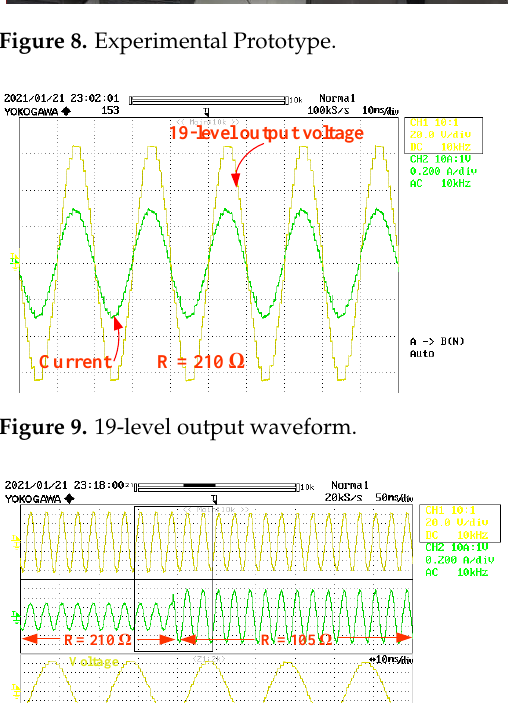
Figure 10. Load change from 210 Ω to 105 Ω.